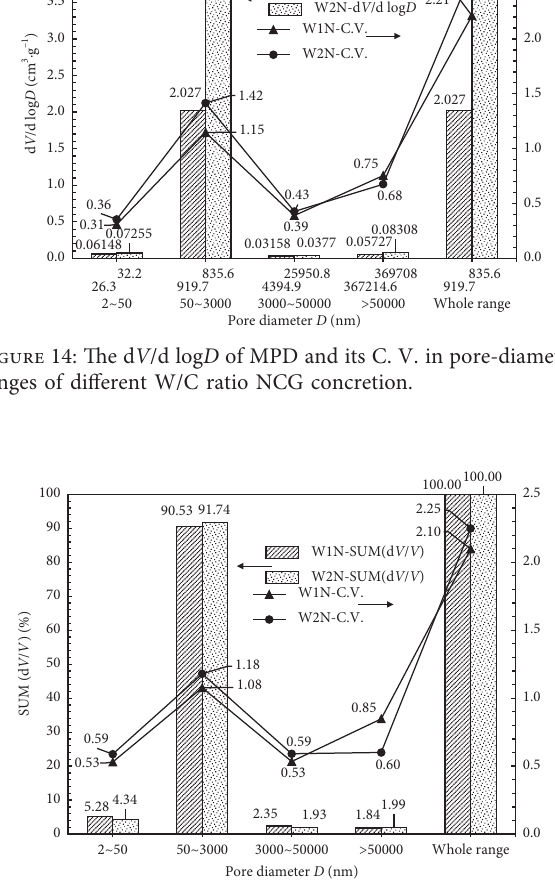
Figure 17: The cumulative pore volume proportion and its C. V. in pore-diameter ranges of different-ages NCG